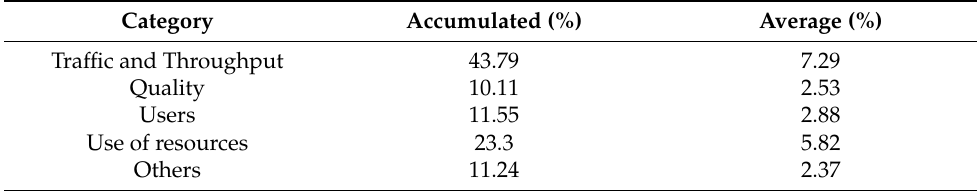
Table 10. Importances per category of